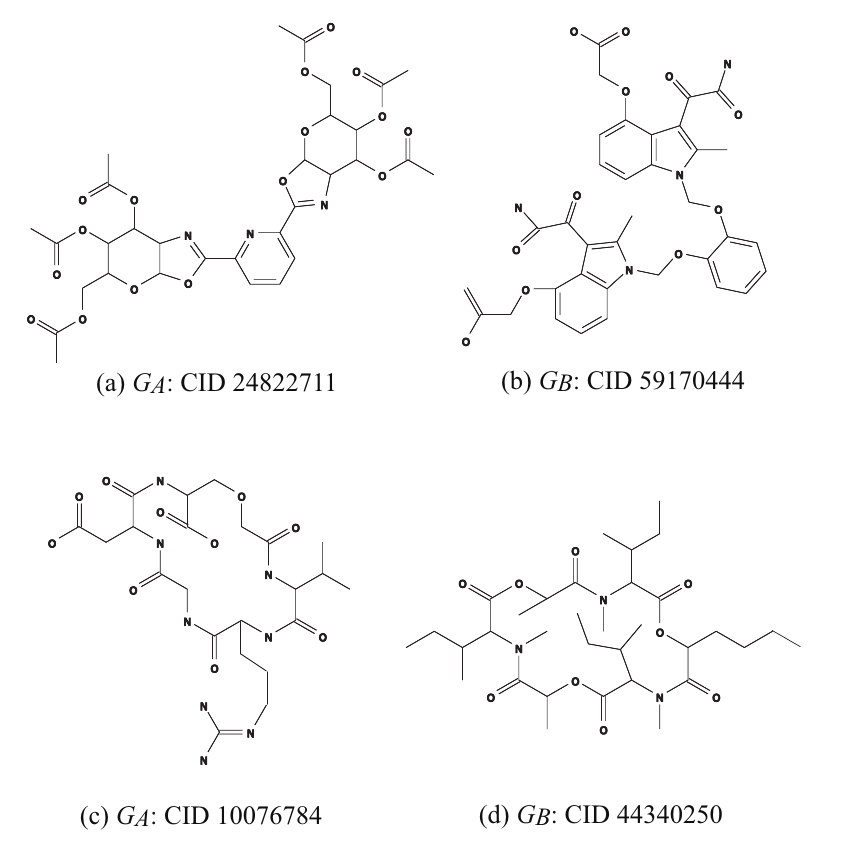
Figure 10. An illustration of chemical compounds for instances I c and I d : ( a ) G A : CID 24822711;